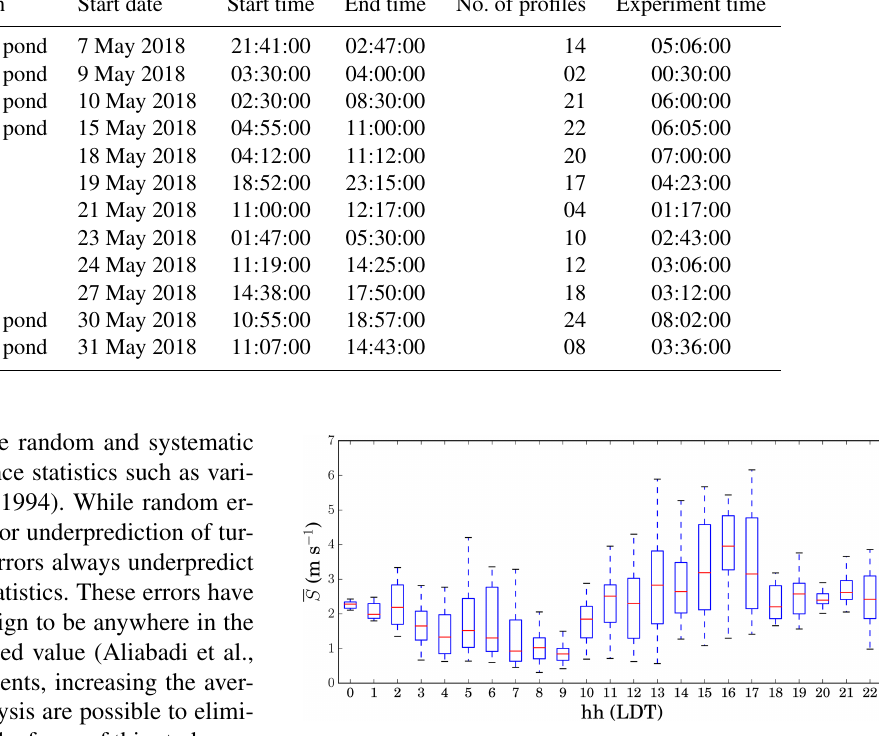
Figure 5. Diurnal variation of wind speed; at each hour, observa- tions are plotted using statistical percentiles (5th, 25th, 50th, 75th, and 95th); times are in LDT.